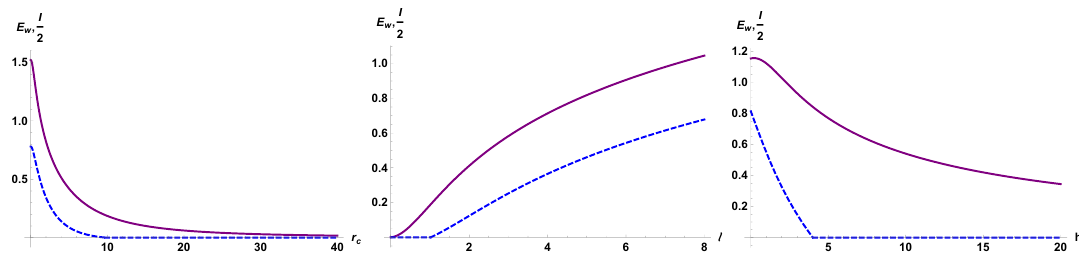
Figure 18 . E W for d e = 1 as a function: Left ) of r c for l = 10 and h = 1 . Middle ) of ‘ for h = 0 . 1 and r = 1 . Right ) of h for ‘ = 10 and r c purple curves are E . Here we renormalized E W